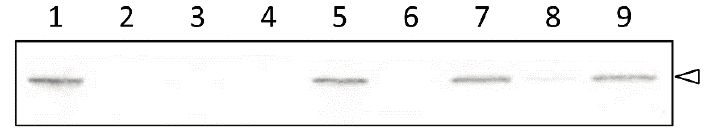
Figure 2. Western blot analysis of the cells grown under iron-replete and iron-depleted conditions. Cells were grown in the absence (lanes 1 to 4) or presence (lanes 5 to 9) of 0.5 mM dipyridyl and the whole cell lysate was subjected to SDS-polyacrylamide gel (10%) electrophoresis followed by visualization with an anti-OprM antibody. The position of OprM is indicated by an arrowhead. Lanes 1 and 5, PAO4290 (wild-type); lanes 2 and 6, TNP072 ( Δ oprM ); lanes 3 and 7, TNP091 ( Δ oprM , fpvA :: oprM ); lanes 4 and 8, TNP092 ( Δ oprM , fpvA :: oprM , Δ pvdS ); lane 9, TNP092